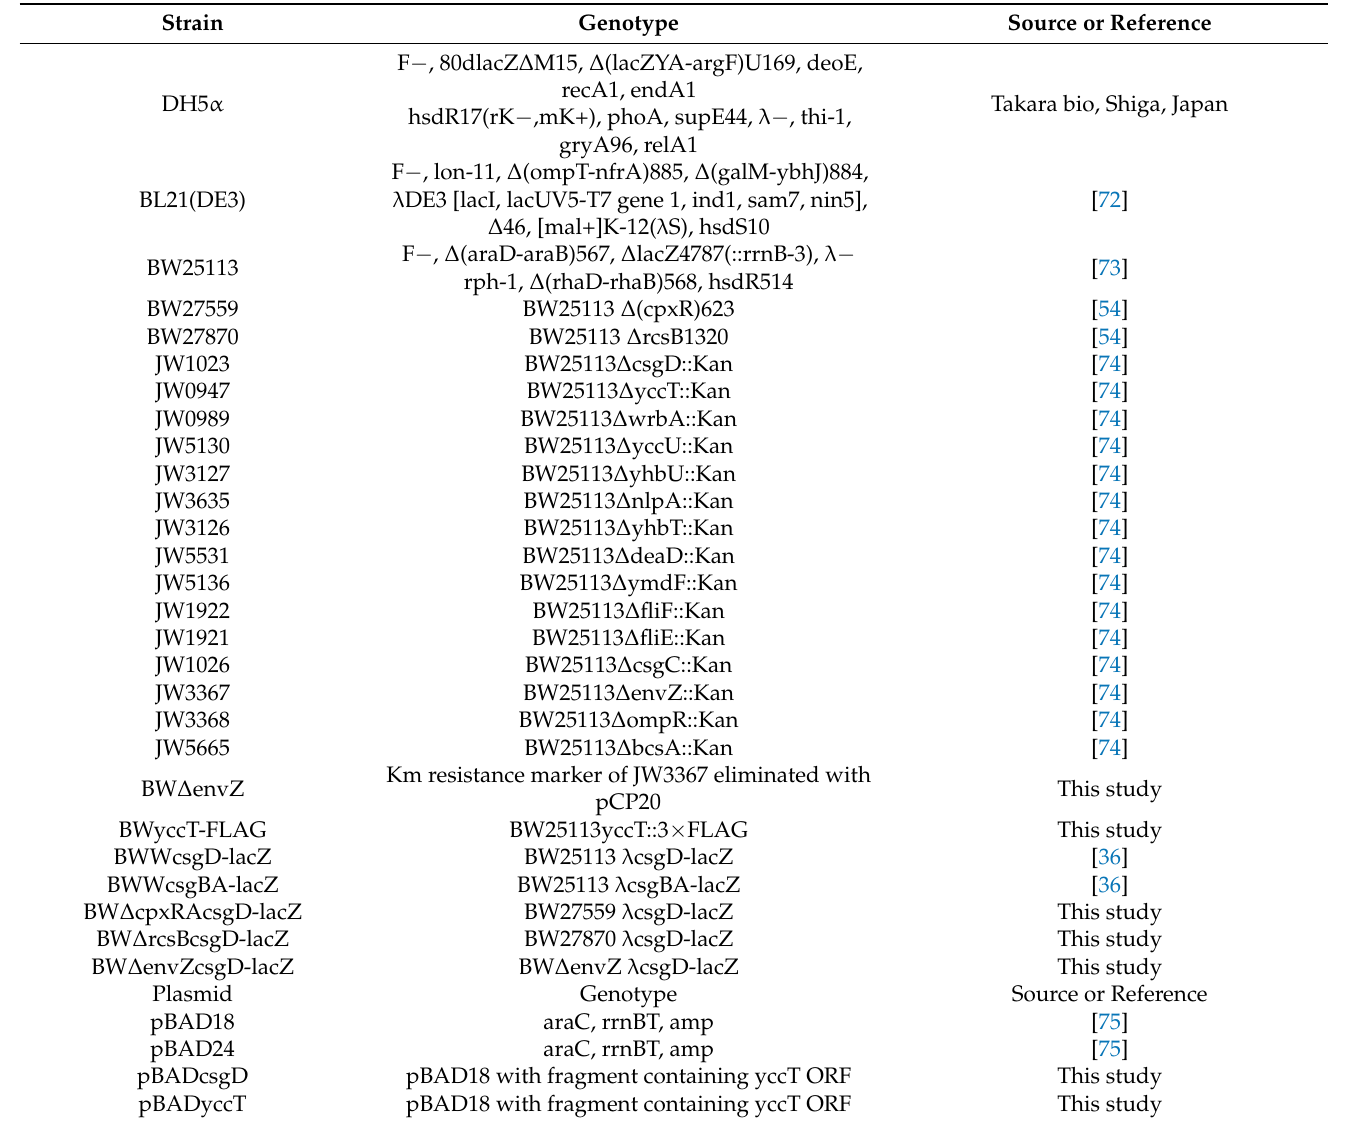
Table 1. Strains, plasmids, and primers used in this